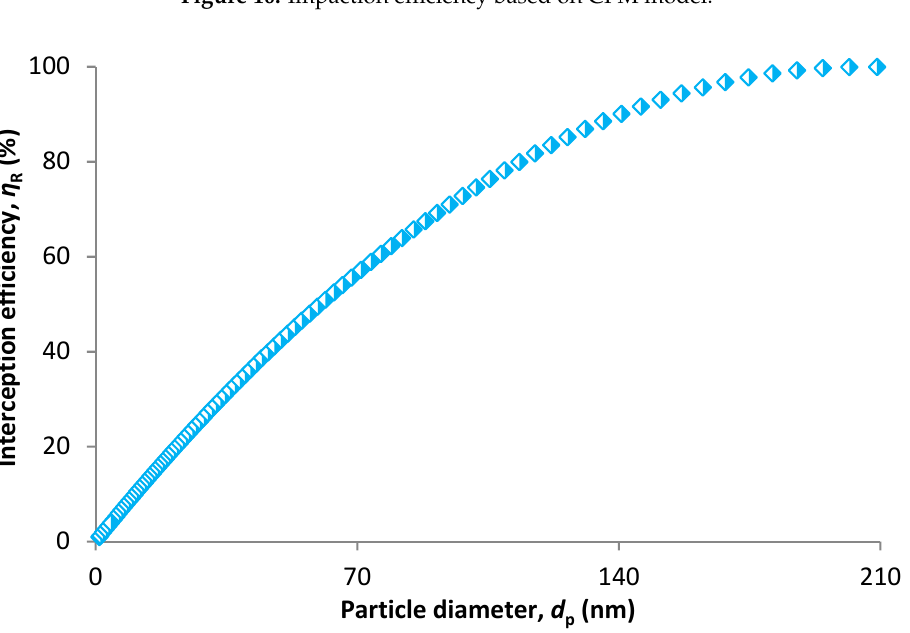
Figure 11. Interception efficiency based on CPM model.